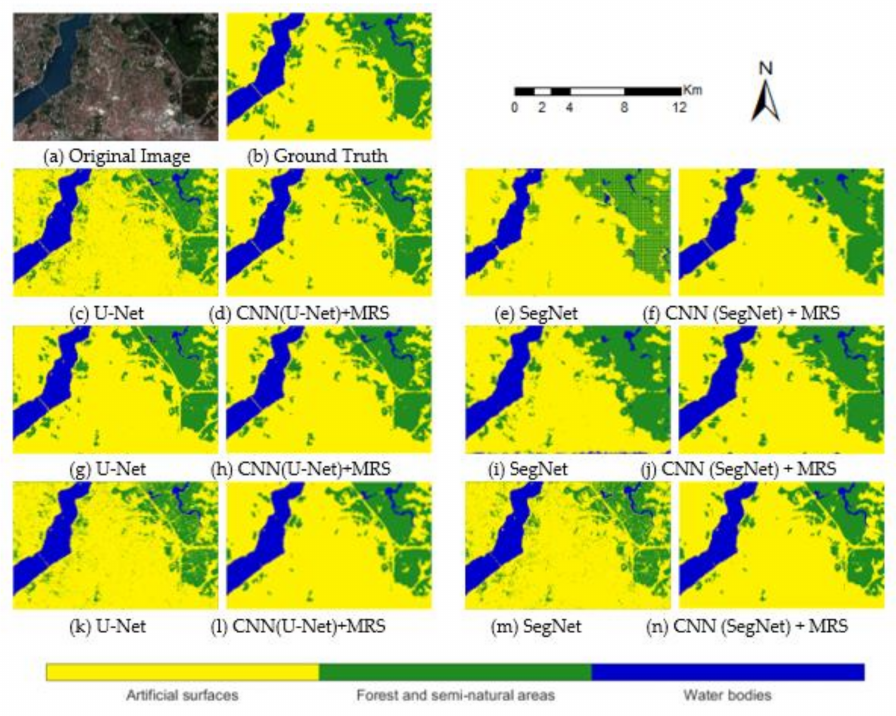
Figure 12. Istanbul test area results of CNN models and CNN–MRS models with 5-band dataset ( c – f ): 32 × 32 patch size; ( g – j ): 64 × 64 patch size; ( k – n ): 128 × 128 patch size.